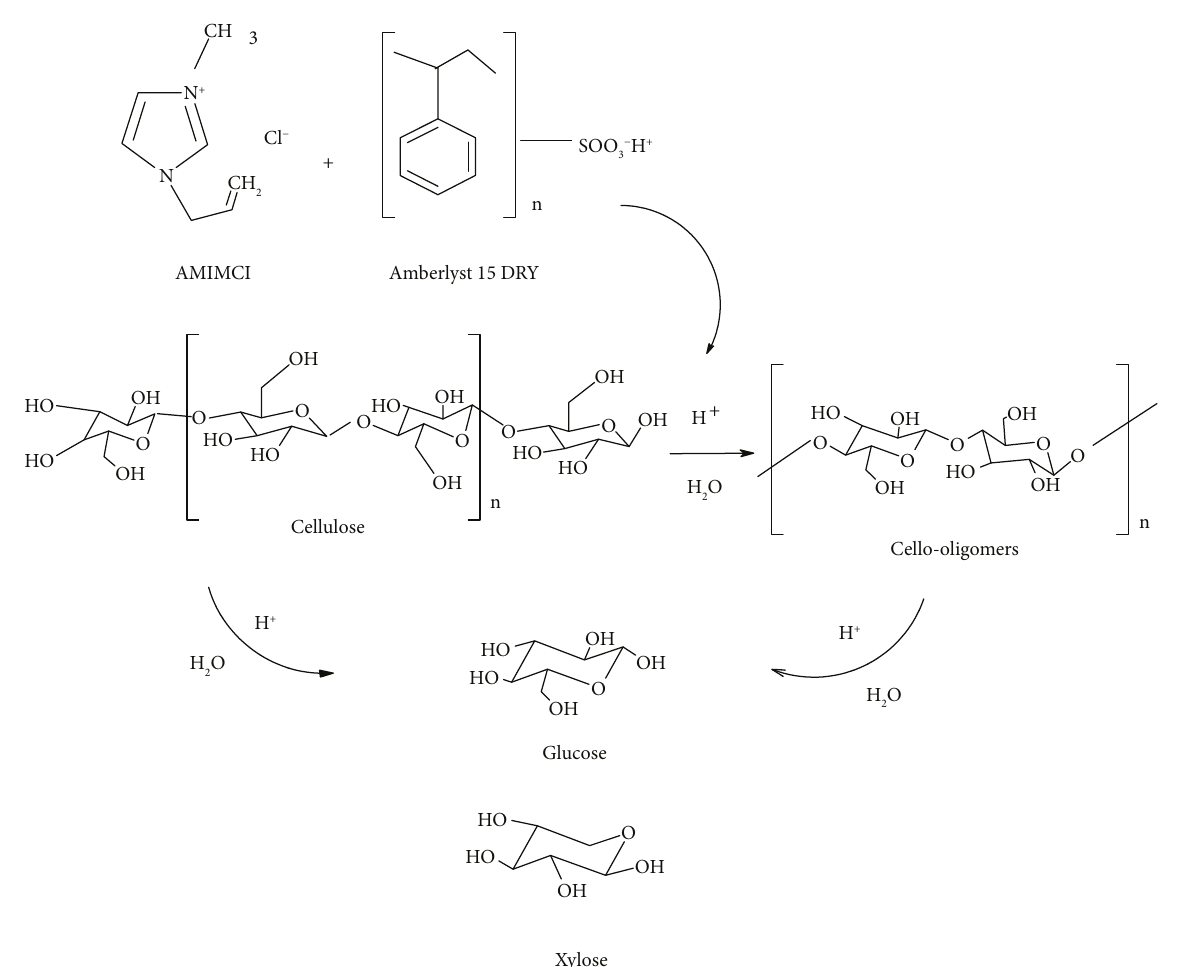
Figure 2: Schematic reaction mechanism for the depolymerization process of cellulose fi bres.